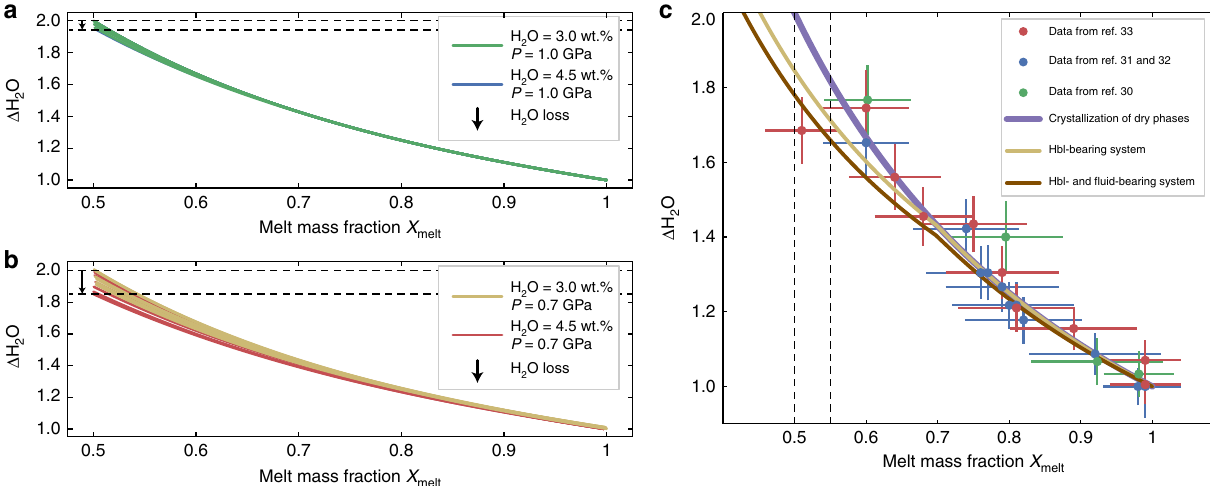
Fig. 2 Water accumulation in the melt phase during crystallization. Evolution of the Δ H 2 O parameter (calculated as ratio between the water content in the residual melt and the initial H 2 O concentration in the system) against the melt mass fraction ( X melt ). a Results of equilibrium thermodynamical simulations performed by rhyolite-MELTS 59 showing the evolution of the Δ H 2 O parameter in the residual melt of a system crystallizing at 1.0 GPa. b Results of equilibrium thermodynamical simulations performed by rhyolite-MELTS 59 showing the evolution of the Δ H 2 O parameter in the residual melt of a system crystallizing at 0.7 GPa. c Mass balance modeling of the Δ H 2 O parameter displaying the evolution of Δ H 2 O parameter during the crystallization of a magmatic system. Different curves are reported for the crystallization of an anhydrous crystal assemblage (purple curve), a hornblende-bearing crystal assemblage (yellow curve), and an over-saturated hornblende-bearing crystal assemblage (brown curve). The data extracted from the investigated petrological data set 30 – 33 are also reported in the picture with error bars expressed as one standard